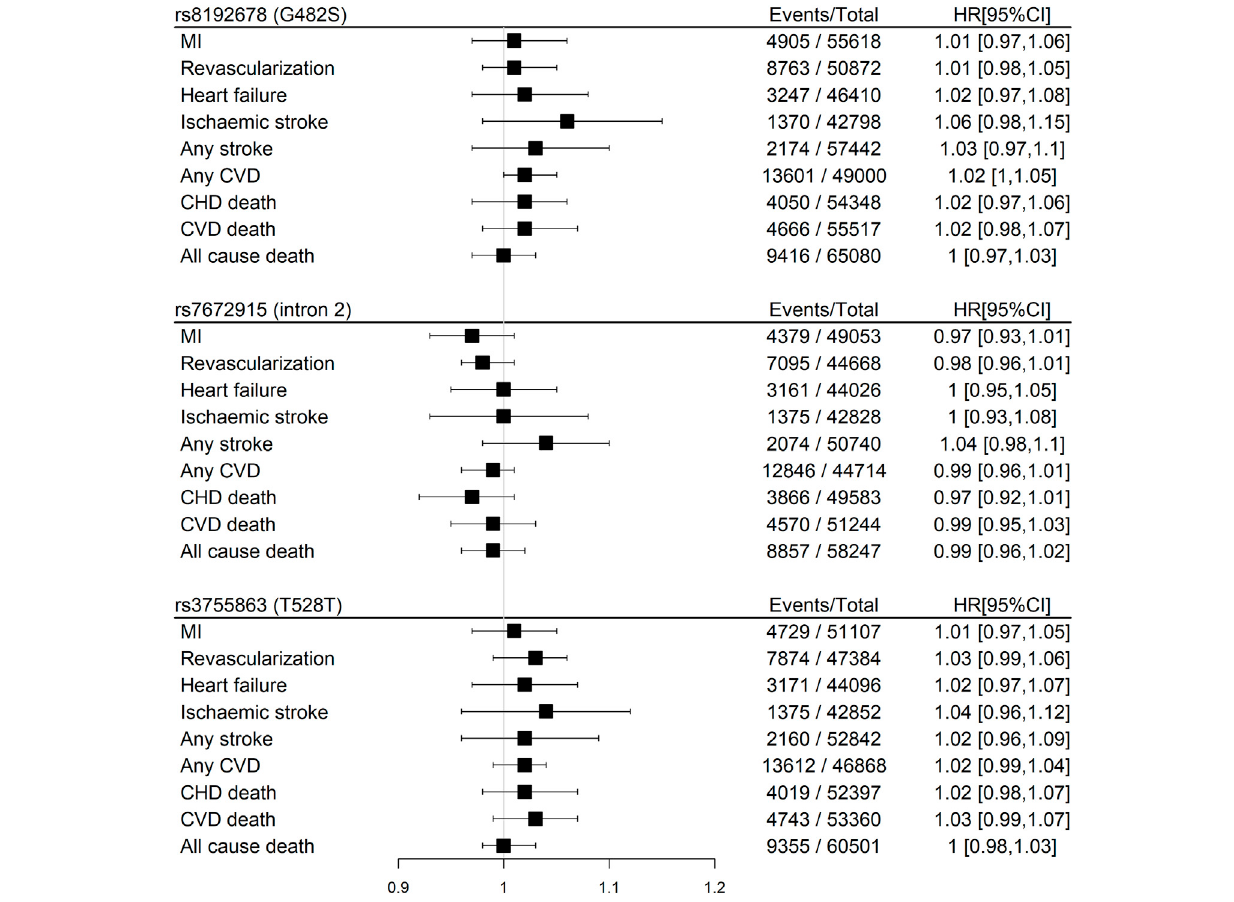
FIGURE 3 | Meta-analyses pooled results of the associations between three SNPs in the PPARGC1A gene and secondary outcomes in participants with baseline CHD within GENIUS-CHD using an additive, fi xed-effect model strati fi ed for age and sex (p homogeneity > 0.05 for all outcomes). Abbreviations: CHD, coronary heart disease; CVD, cardiovascular disease; MI, myocardial